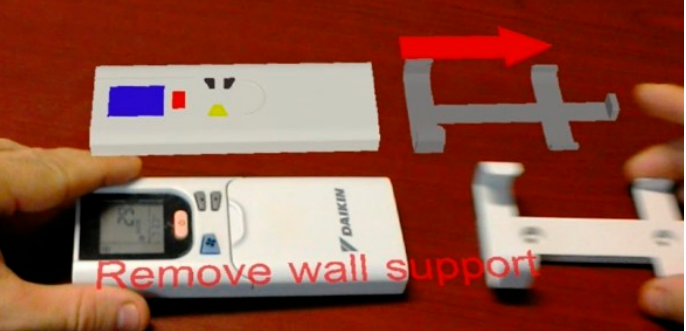
Figure 6. Application of Design for Disassembly developed at University of Bologna.